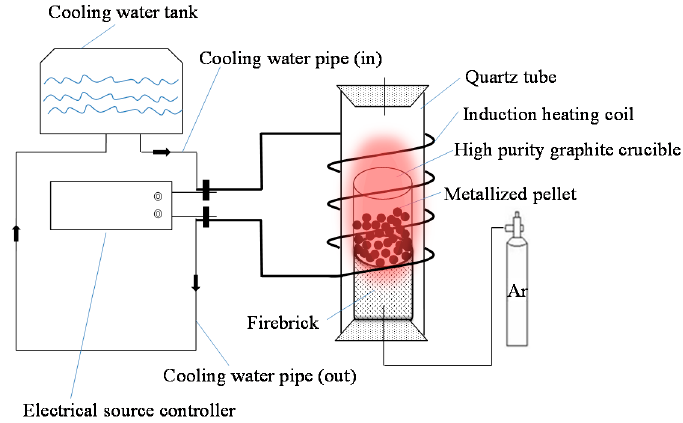
Figure 7. Schematic of the medium frequency induction furnace.